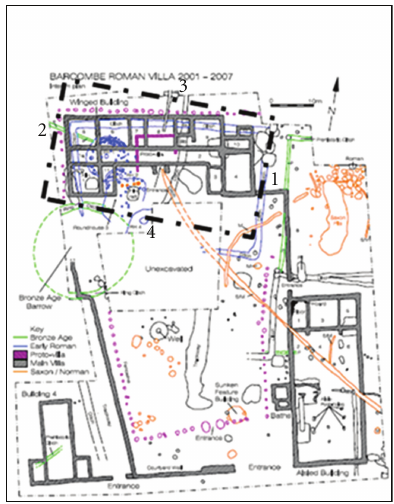
Figure 7: Excavation plan of Barcombe Romano-British Villa. The area of the GPR survey is put into evidence by the black dashed